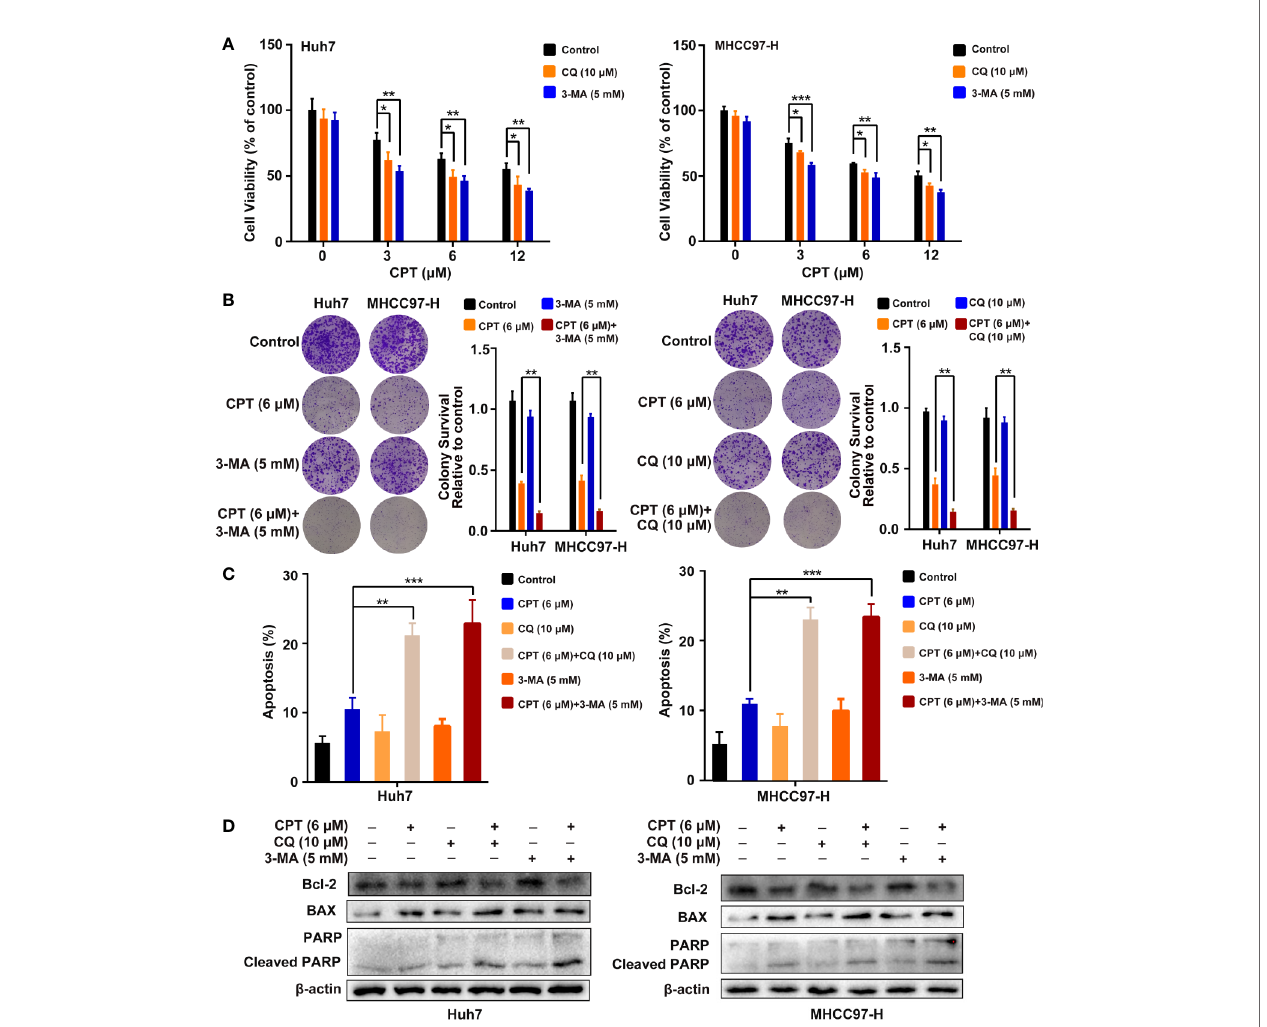
FIGURE 9 | Inhibition of cryptotanshinone (CPT)-induced autophagy promotes cell apoptosis in Huh7 and MHCC97-H cells. (A) Huh7 and MHCC97-H cells were treated with different concentrations of CPT alone or in combination with 10 m M chloroquine (CQ) or 5 mM 3-methylamphetamine (3-MA) for 24 h. Cell viability was detected by 3-(4,5-dimethylthiazol-2-yl)-2,5-diphenyltetrazolium bromide (MTT) assay. * P < 0.05, ** P < 0.01, and *** P < 0.001 versus the control group. (B) Huh7 and MHCC97-H cells were treated with 6 m M CPT alone or in combination with 10 m M CQ or 5 mM 3-MA for 24 h. Proliferative capacity was measured using a colony formation assay. ** P < 0.01 versus the CPT group. (C) Flow cytometric analysis of apoptosis in Huh7 and MHCC97-H cells exposed to 6 m M CPT alone or in combination with autophagy inhibitors (3-MA or CQ) for 24 h. ** P < 0.01, *** P < 0.001 versus the CPT group. (D) Western blot analysis of PARP, cleaved-PARP, Bcl-2, and Bax in human hepatocellular carcinoma (HCC) cells treated with 6 m M CPT alone or in combination with autophagy inhibitors (3-MA or CQ) for 24